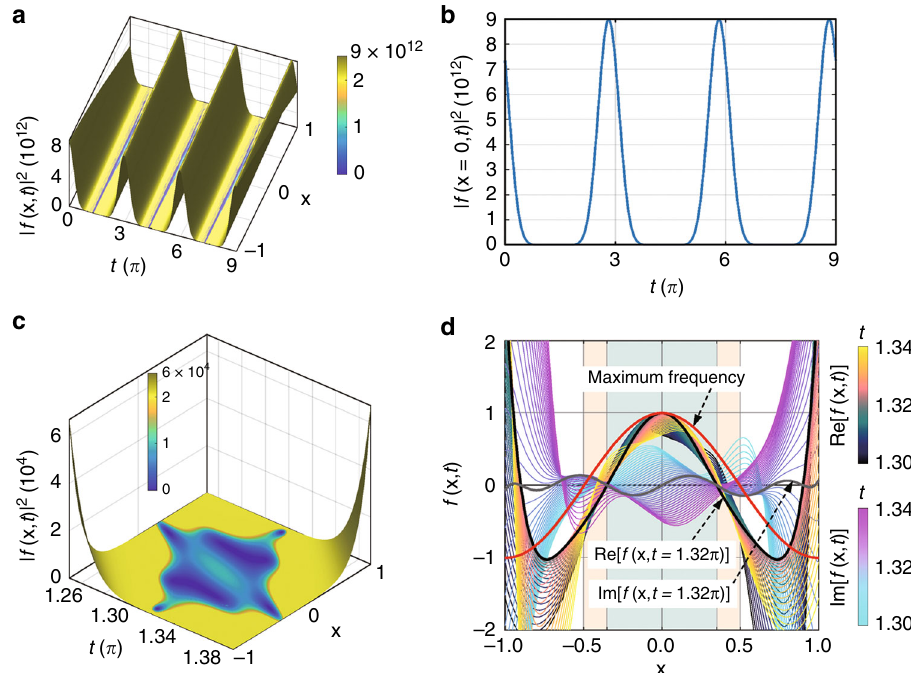
Fig. 1 Construction of super-oscillatory packets. a Revivals of the super-oscillation wave function in time. b The distribution of the wave function j f ð x ; t Þj 2 along x ¼ 0. c Zooming-in display of the super-oscillatory region when t ¼ 1 : 26 π (cid:1) 1 : 38 π . d Real and imaginary parts of this super-oscillation wave function when t ¼ 1 : 3 π (cid:1) 1 : 34 π . The pseudo-colors in the upper (lower) bars represent the evolving time for the real (imaginary) parts of the wave